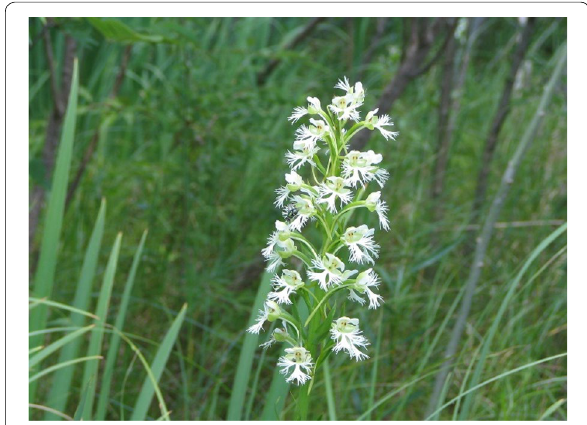
Fig. 1 The U.S. Federally-listed (threatened) Eastern Prairie Fringed Orchid, Platanthera leucophaea (Nutt.) Lindl. (Photo courtesy of Dr. Timothy J.